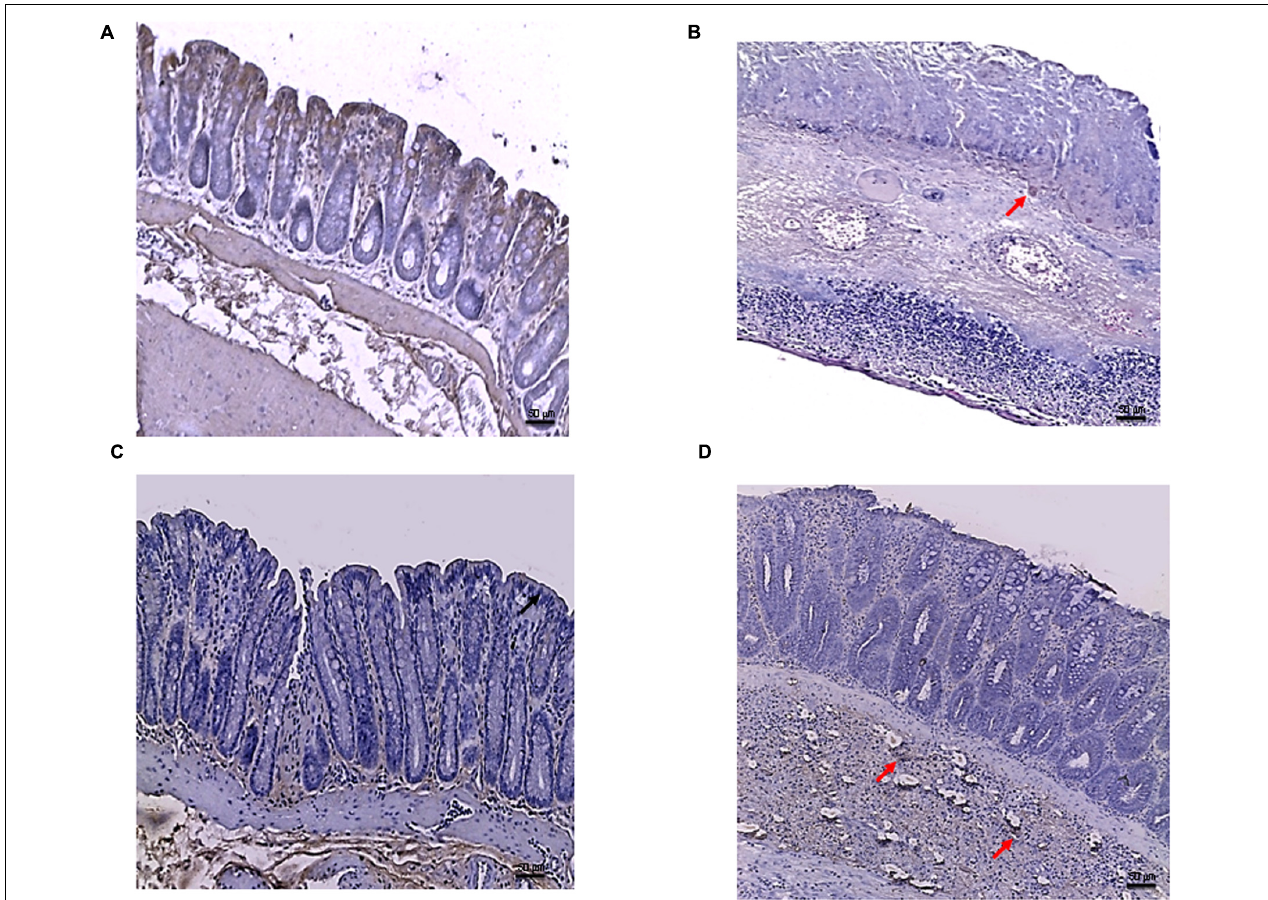
FIGURE 8 | Bcl-2 immunostaining from DSS-treated animals. Representative images of Bcl-2 immunostaining (original magnification 10 × ) of colons derived from control (A) , DSS + drug vehicle (B) , DSS + PDRN (C) , or DSS + PDRN + DMPX (D) treated animals are shown. The image in (A,C) demonstrate diffuse staining for Bcl-2, while the arrows in (B,D) point to residual Bcl-2 staining in the mucosal layer. Scale bar 50 µ